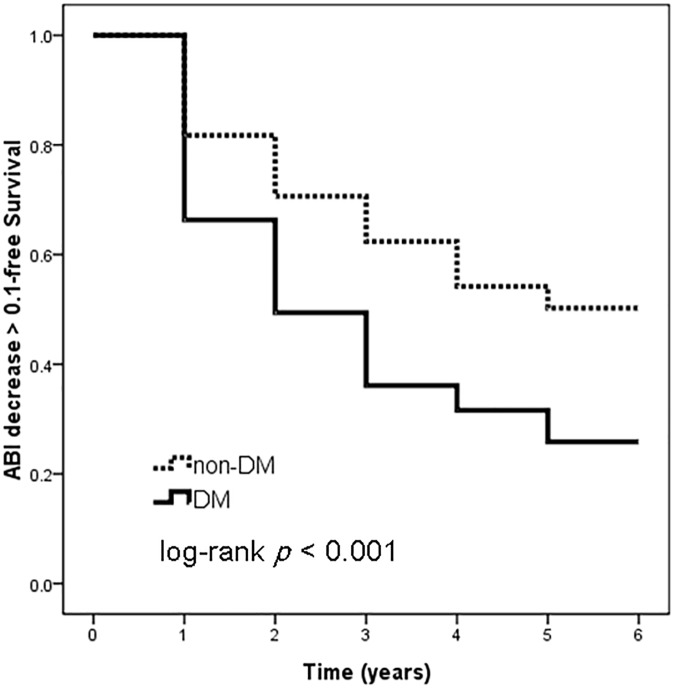
Kaplan-Meier analyses of ABI decrease > 0.1-free survival in patients with a baseline ABI ≥ 0.9.DM patients had worse ABI decrease > 0.1-free survival (log-rank test, p < 0.001) than non-DM patients.